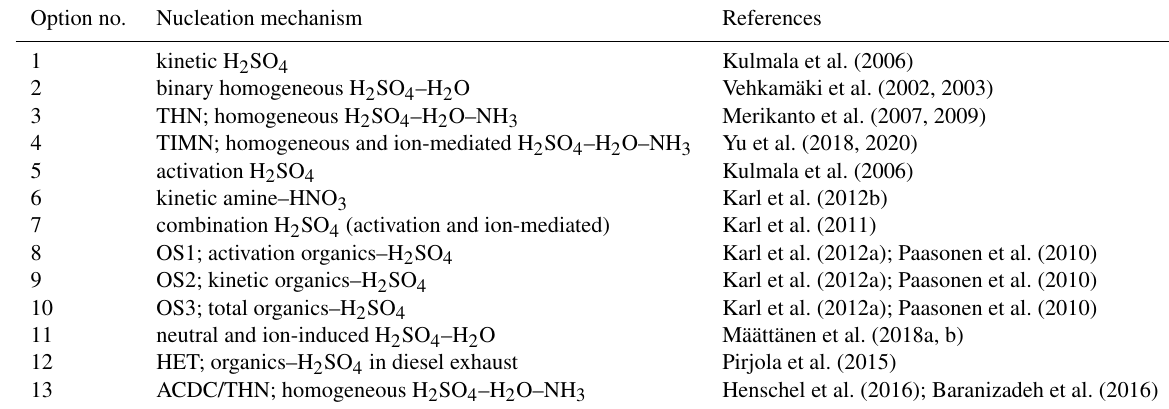
Table 3. Nucleation options in the MAFOR model. Option